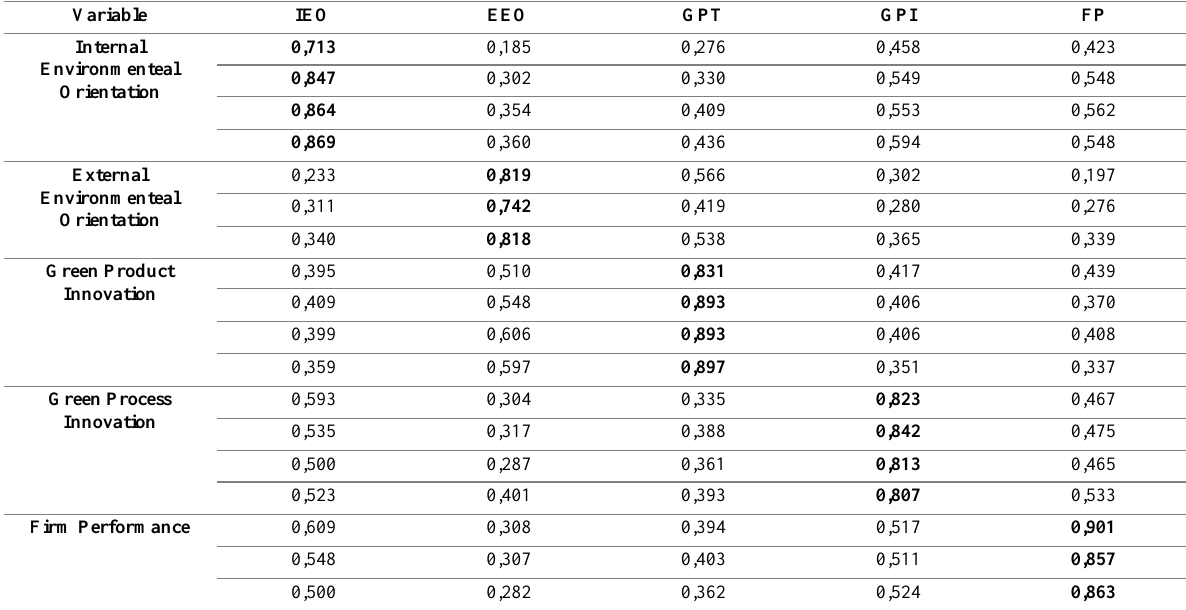
Table 3: Results of loadings and cross loadings